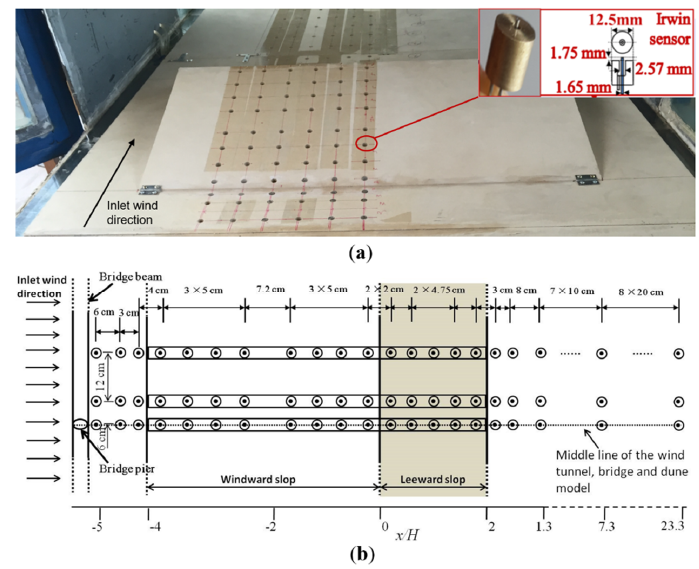
Figure 3. ( a ) Irwin sensor and the installation sites on dune model during the wind tunnel test, ( b ) Installation dimension of Irwin sensors.